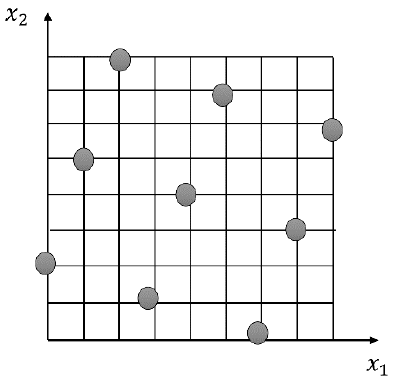
Figure 6. An example of a Latin Hypercube Sampling (LHS) with two factors and both nine design points and factor levels.